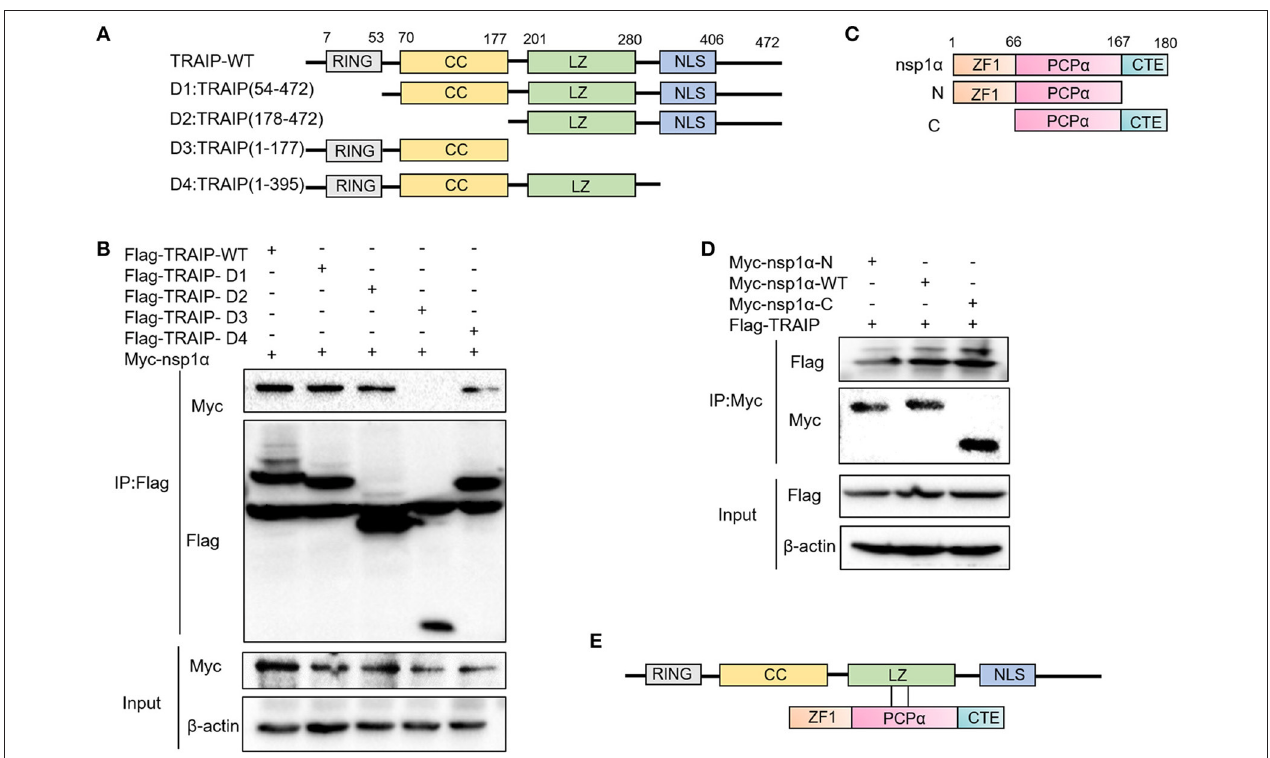
FIGURE 5 | The LZ domain of TRAIP interacts with PCP α of nsp1 α . (A) Mapping of wild-type (WT) TRAIP and different key enzyme truncated of TRAIP. TRAIP is consisted of a RING domain, a Coiled coil (CC) domain, a Zipper domain, and nuclear localization signals (NLS). (B) HEK293T cells were co-transfected with Myc-nsp1 α and different Flag-tag TRAIP deletion mutants plasmids. Cells were harvested and lysed, and immunoprecipited (IP) with Flag-conjugated beads. (C) Mapping of wild-type (WT) nsp1 α and internal deletion mutants. Nsp1 α is consisted of a papain-like cysteine protease α (PCP α ) motif, an N-terminal zinc finger motif (ZF1), and the carboxyl-terminal extension (CTE). (D) Flag-TRAIP interacts with the PCP1 α domain of nsp1 α . (E) The model of TRAIP interacts with nsp1 α was